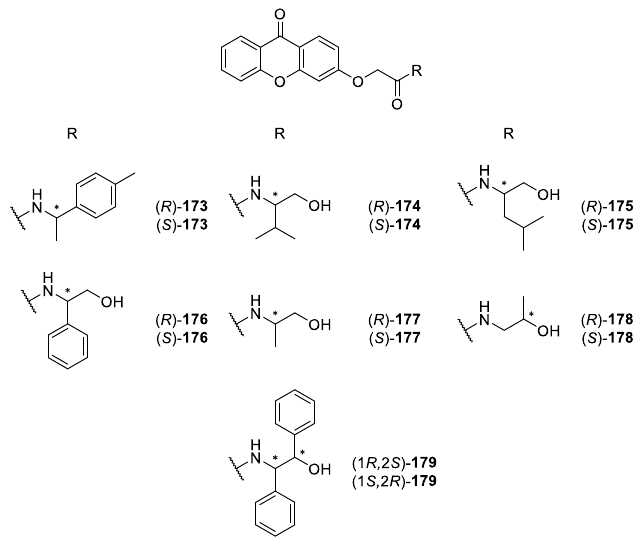
Molecules 2019 , 24 , x FOR PEER REVIEW Figure 16. Structures of aminoalkanolic CDXs 166 – 171 and analogues 165 and 172 .